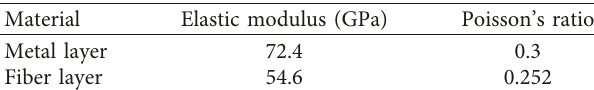
Figure 4: The structure diagram of 2/1 laminates and 3/2 laminates. Table 1: Laminate component material property.